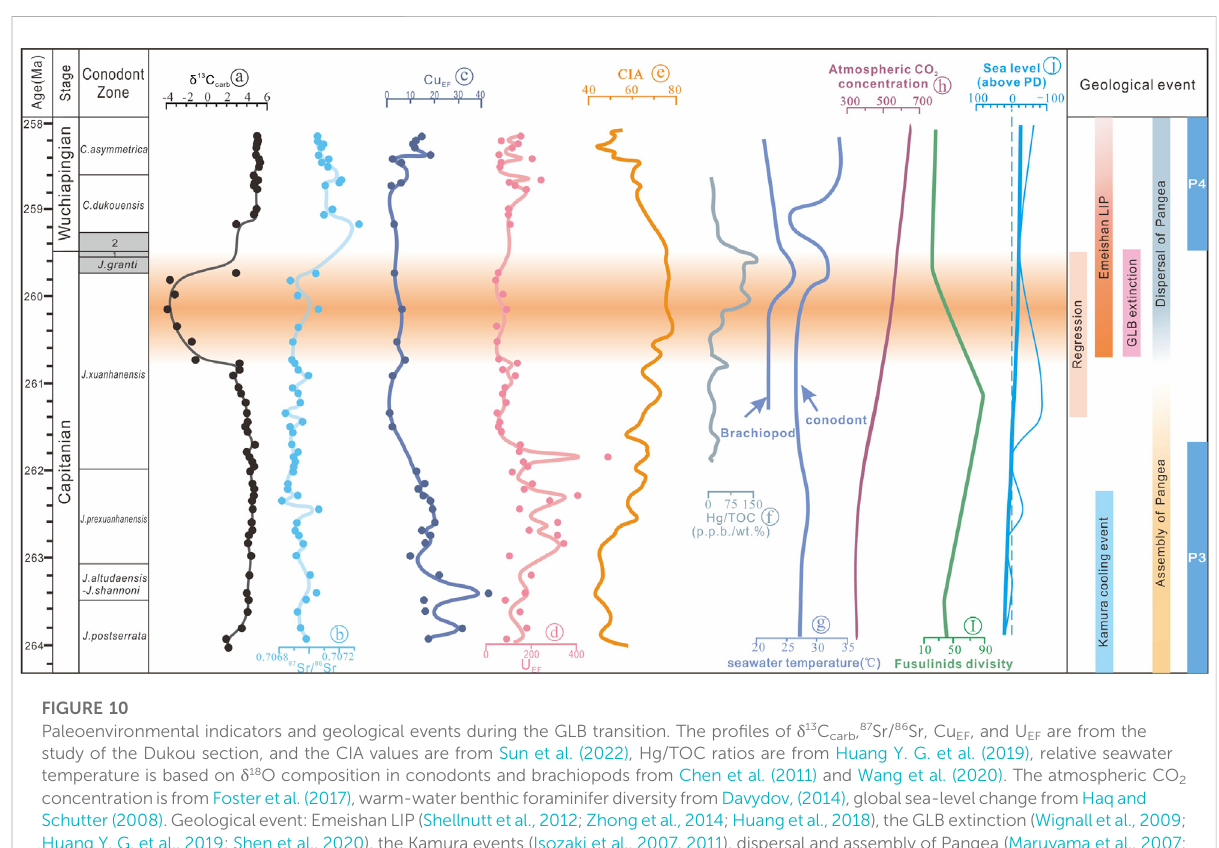
FIGURE 10 Paleoenvironmental indicators and geological events during the GLB transition. The pro fi les of δ 13 C carb , 87 Sr/ 86 Sr, Cu EF , and U EF are from the study of the Dukou section, and the CIA values are from Sun et al. (2022), Hg/TOC ratios are from Huang Y. G. et al. (2019), relative seawater temperature is based on δ 18 O composition in conodonts and brachiopods from Chen et al. (2011) and Wang et al. (2020). The atmospheric CO 2 concentrationisfromFosteretal.(2017),warm-waterbenthicforaminiferdiversityfromDavydov,(2014),globalsea-levelchangefromHaqand Schutter(2008).Geologicalevent:EmeishanLIP(Shellnuttetal.,2012;Zhongetal.,2014;Huangetal.,2018),theGLBextinction(Wignalletal.,2009; Huang Y. G. et al., 2019; Shen et al., 2020), the Kamura events (Isozaki et al., 2007, 2011), dispersal and assembly of Pangea (Maruyama et al., 2007; Isozaki, 2009; Santosh et al., 2009; Shen et al., 2019). The duration of P3-P4 glacial (Metcalfe et al., 2015), sea-level change (Haq and Schutter, 2008). Abbreviations: P3 = the third stage of Permian glaciation, P4 = the fourth stage of Permian glaciation, 1 = Clarkinapostbitteri hongshuiensis , 2 = Clarkina postbitteri postbitteri , geological age and conodont biostratigraphy is based on Shen et al. (2019) and Shen et al.